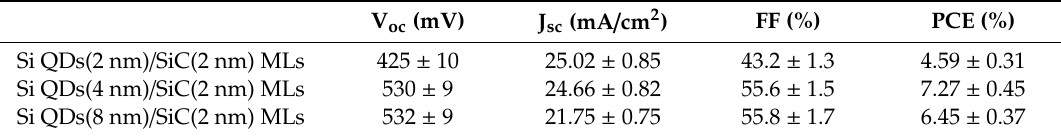
Figure 5. J - V curves of solar cells with Si QDs / SiC MLs of di ff erent sizes under the illumination of AM1.5G. Table 1. Device parameters of di ff erent-sized Si QDs / SiC MLs-based solar